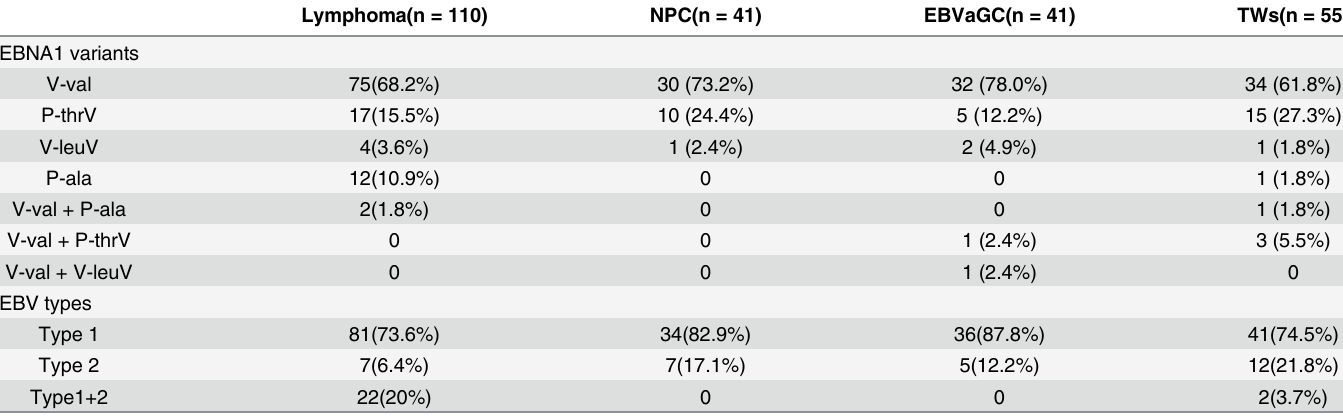
Table 2. The distribution of EBNA1variants and EBV types in lymphomas, nasopharyngeal carcinomas, EBVaGCs and throat washing samples from healthy